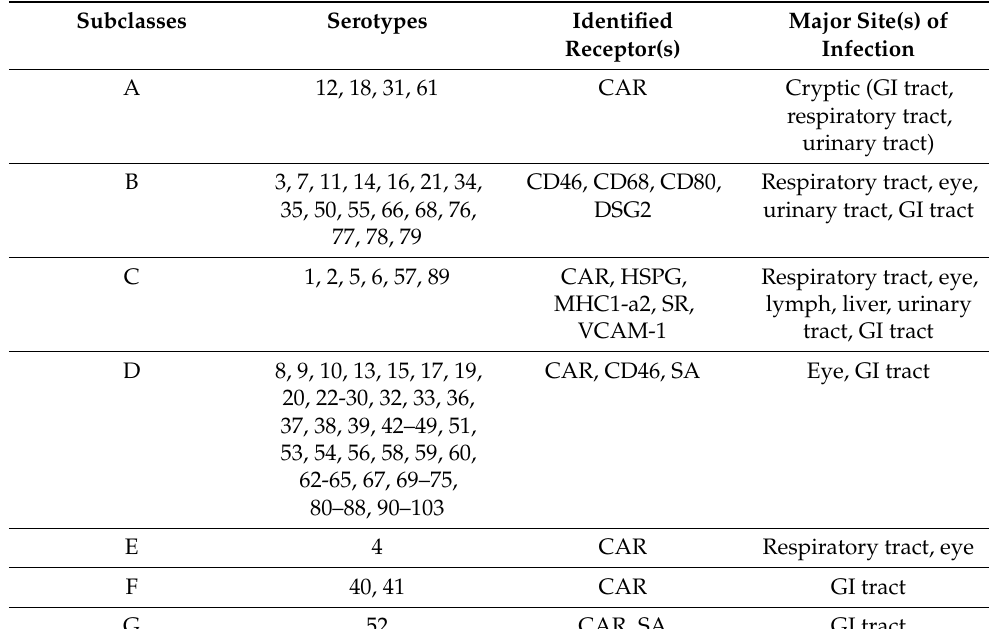
Figure 1. HAdV structure. Table 1. Classification of HAdV and its receptors (information summarized from Arnberg et al. (2012) [39] and Gao et al. (2020)